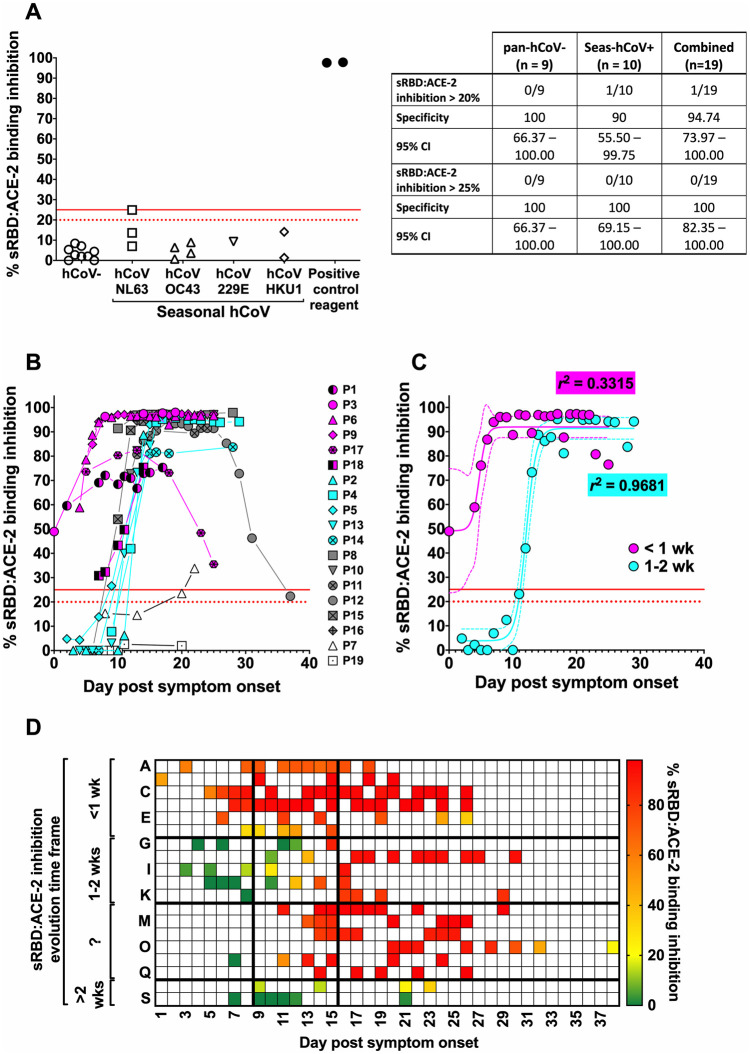
RBD:ACE-2 binding inhibition potency of antibodies produced over seroconversion.Serum samples collected from the cohort members following the onset of symptoms were analysed for RBD:ACE-2 binding inhibition potency by the GenScript surrogate Virus Neutralisation Test (sVNT). (A) An assessment of the assay specificity was conducted using hCoV seronegative sera (n = 9) and seasonal hCoV sera (n = 10). The calculated sensitivity and specificity of the anti-RBD IgG ELISA are described in the table. (B) Individual time-course data and (C) best-fit curves for RBD:ACE-2 inhibition evolving after < 7 days or between 7–14 days pso. In B+C–the manufacturer’s suggested sVNT assay cut-off (20% sRBD:ACE-2 binding inhibition relative to the negative control) is indicated by broken red line, and the ‘in-house’ applied cut-off (25%) is indicated by solid red line. Patients #1 and #18 were considered outliers and were therefore excluded from best-fit curve analyses. In C–dashed lines indicate 95% CI ranges; r2 values describe tightness of fit. (D) Data from B presented as a heat-map. ‘?’ indicates undetermined seroconversion time frame.